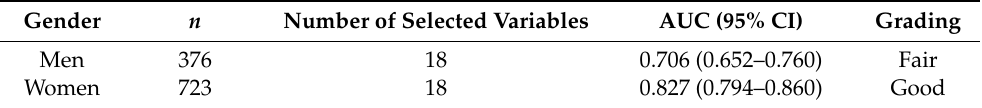
Table 8. Calculated AUC values.